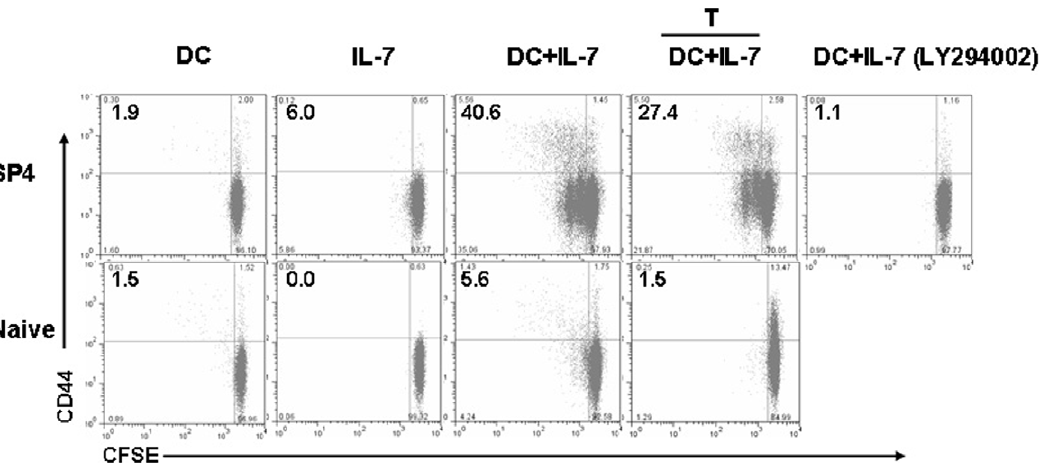
Figure 5. Comparison of the proliferation of pre-RTEs and naı¨ve T cells in T-DC coculture system. Purified pre-RTEs (SP4 thymocytes) and naı¨ve CD4 + T cells were labeled with CFSE and cultured with FLDCs at 10:1 ratio. The proliferation and CD44 upregulation were analyzed 4 days later. The fourth column displayed the T-DC coculture in the transwell system. T cells and DCs were separated by 0.4 m m transwell membrane. In the last column, Ly294002 was added to the T-DC coculture at 10 ng/ml. The numbers in the plot indicate the percentage of cells that diluted CFSE. The experiment was repeated for at least 3 times.